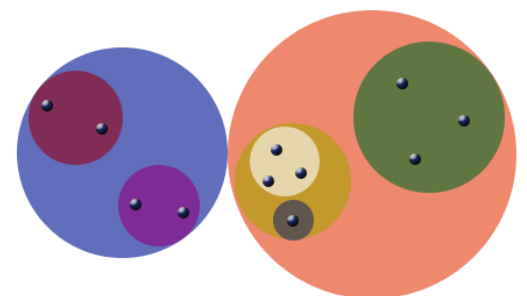
Figure 1: Hierarchical partitioning of a point set (blue dots) using the ball-tree model. Nodes are represented as colored